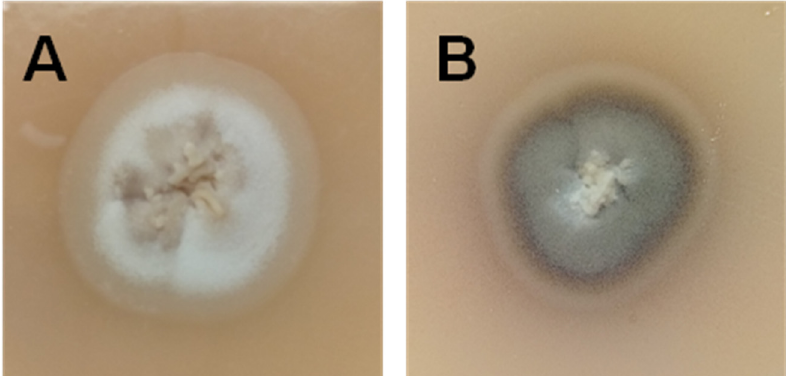
Figure 1. ( A ) Light” (or albino) and ( B ) “Dark” (or pigmented) S. brasiliensis phenotypes isolated from the face lesions and nail tips, respectively, of a sick cat from Argentina with the lymphocutaneous form of the disease.